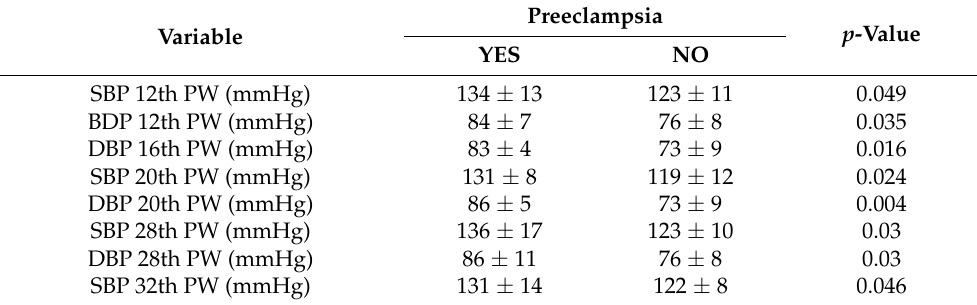
Table 2. Significant differences in blood pressure among patients who were affected by PE. Abbrevia-